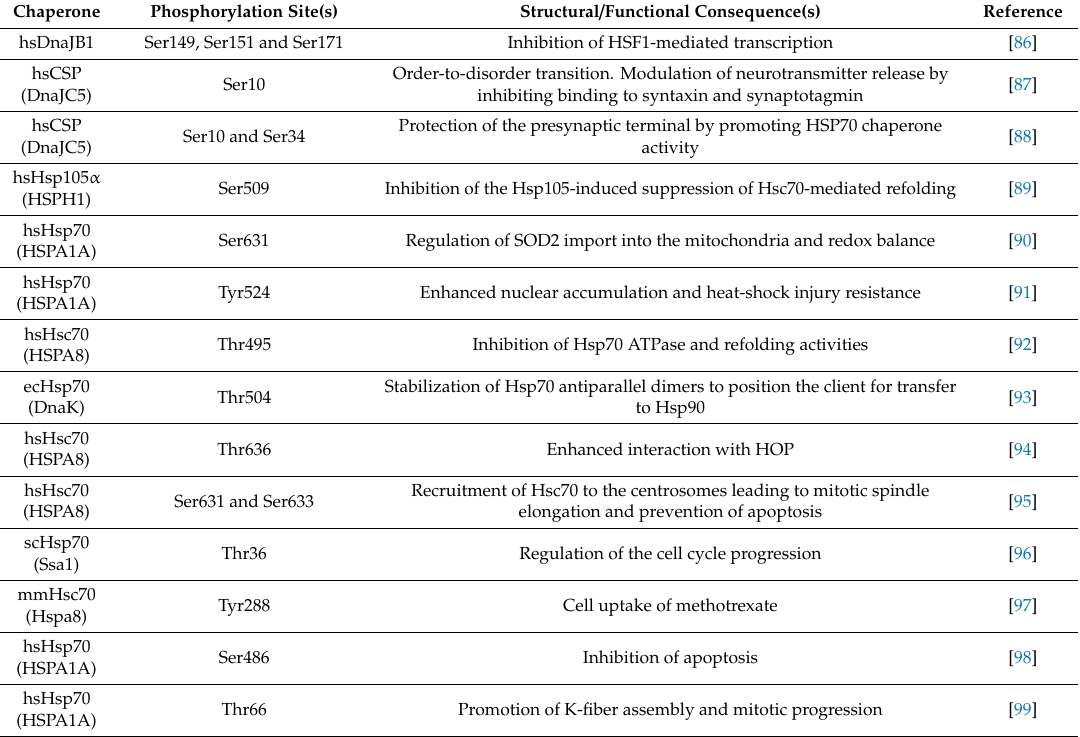
Table 1. Phosphorylation sites identified in members of the Hsp70, Hsp40, and Hsp110 chaperone families with known e ff ects on their structure and function. hs: Homo sapiens ; sc: Saccharomyces cerevisiae ; ec: Escherichia coli ; mm: Mus musculus